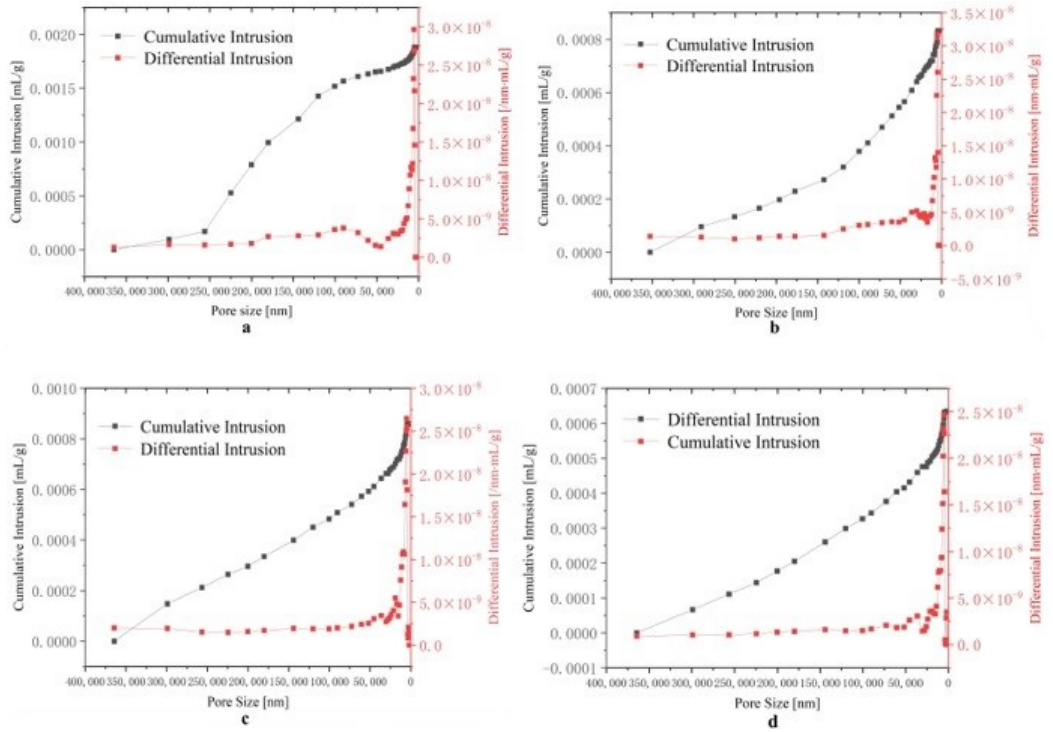
Figure 6. Mercury injection curves of four alloys: ( a ) MSB_0 alloy, ( b ) MSB_0.5 alloy, ( c ) MSB_1.5 alloy and ( d ) MSB_2.5 alloy.